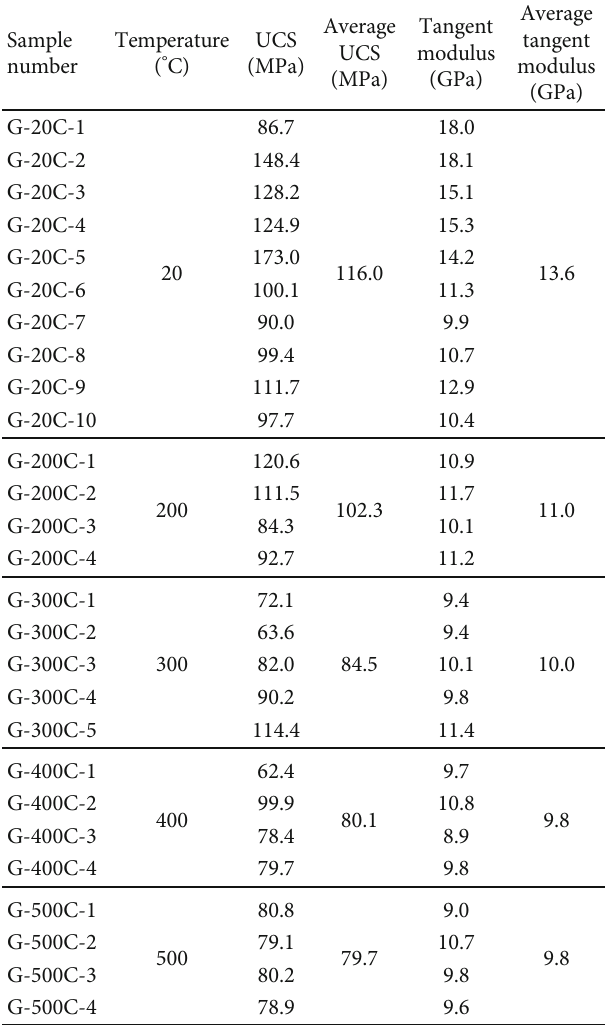
Table 1: The UCS and tangent modulus of granite under high